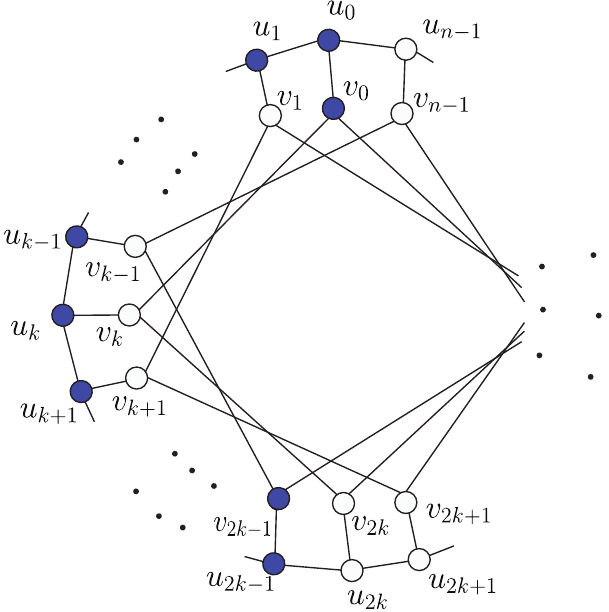
Figure 2: A Generalized Petersen graph (shown with a zero forcing